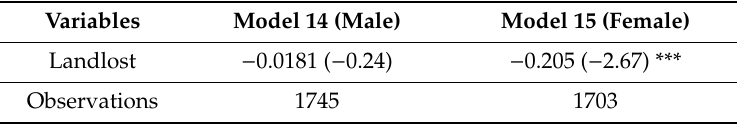
Table 8. Mechanism a ff ecting health status: gender di ff